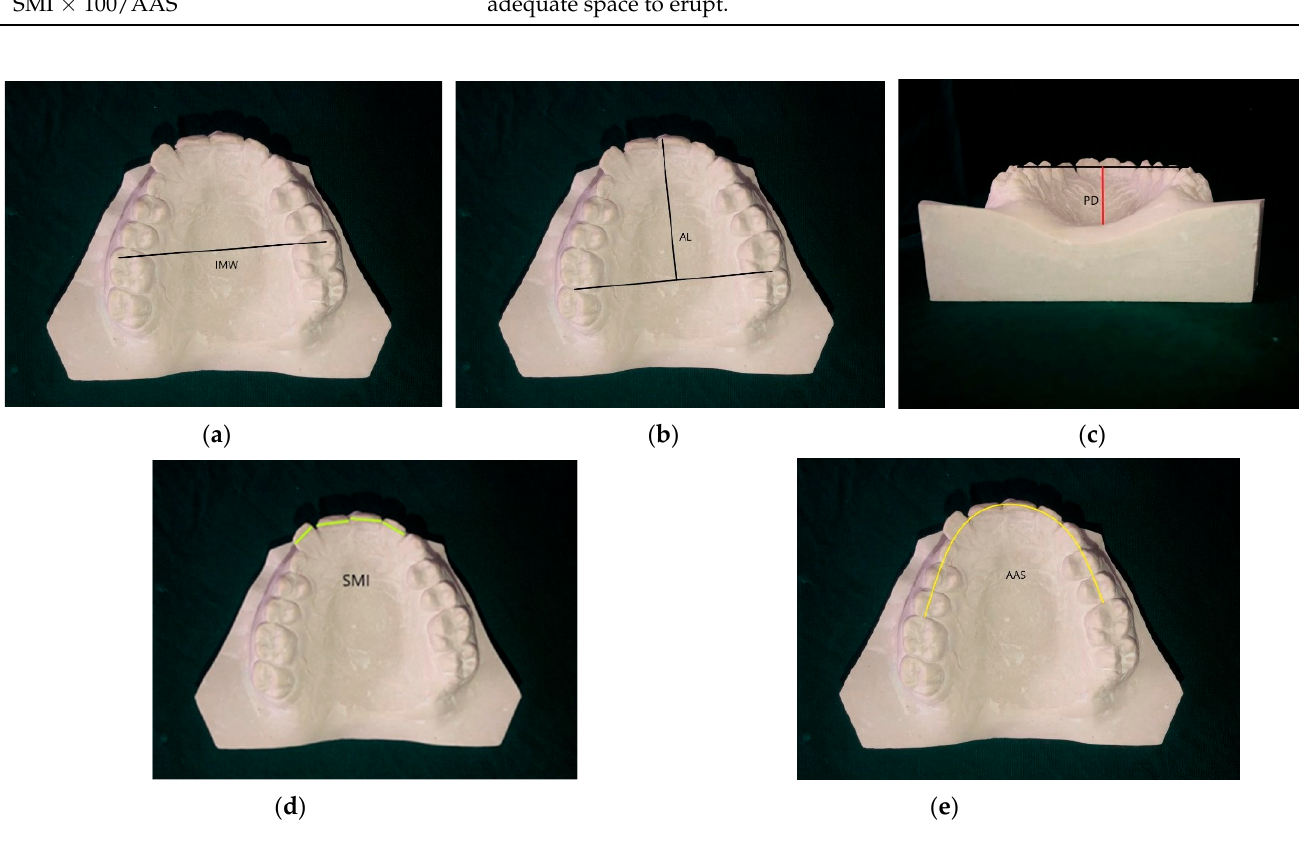
Figure 2. Maxillary Arch Measurements: ( a ) inter-molar width; ( b ) arch length; ( c ) palatal depth ( d ) sum of maxillary incisors; ( e ) available arch space.